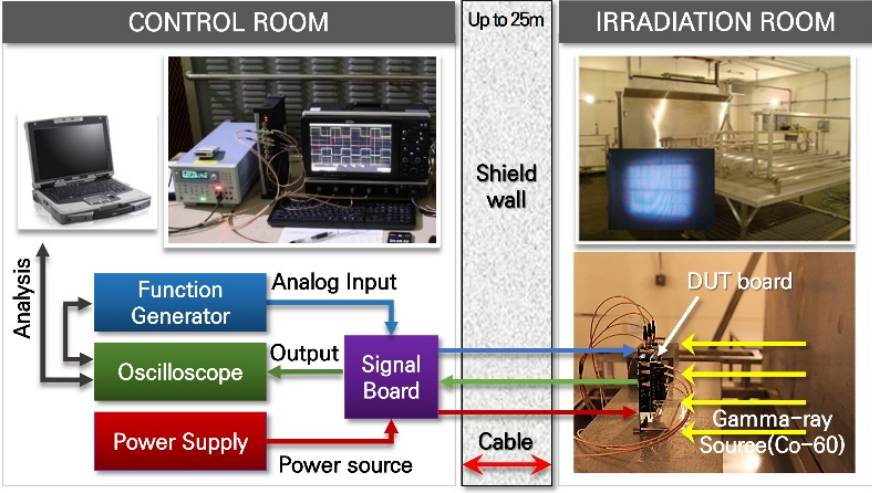
Figure 18. TID effect test evaluation setup of the pulsed gamma ray detection circuit. Table 2. TID effect test conditions and test method of pulsed-radiation detection chip.